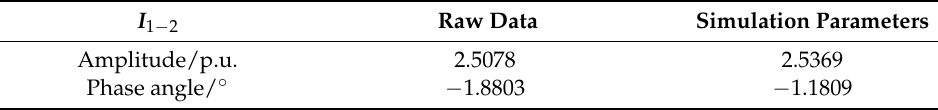
Table 1. Simulation parameters.